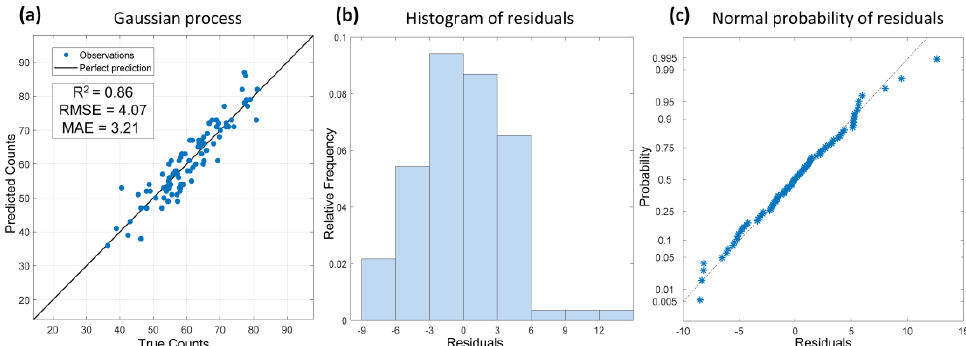
Figure 4. Dedicated validation of Gaussian processed regression (GPR) model results: (a) GPR model relationship, (b) Histogram of residuals plot and (c) Normal probability of residuals. True counts are manually measured seedling emergences and predicted counts use a given model.